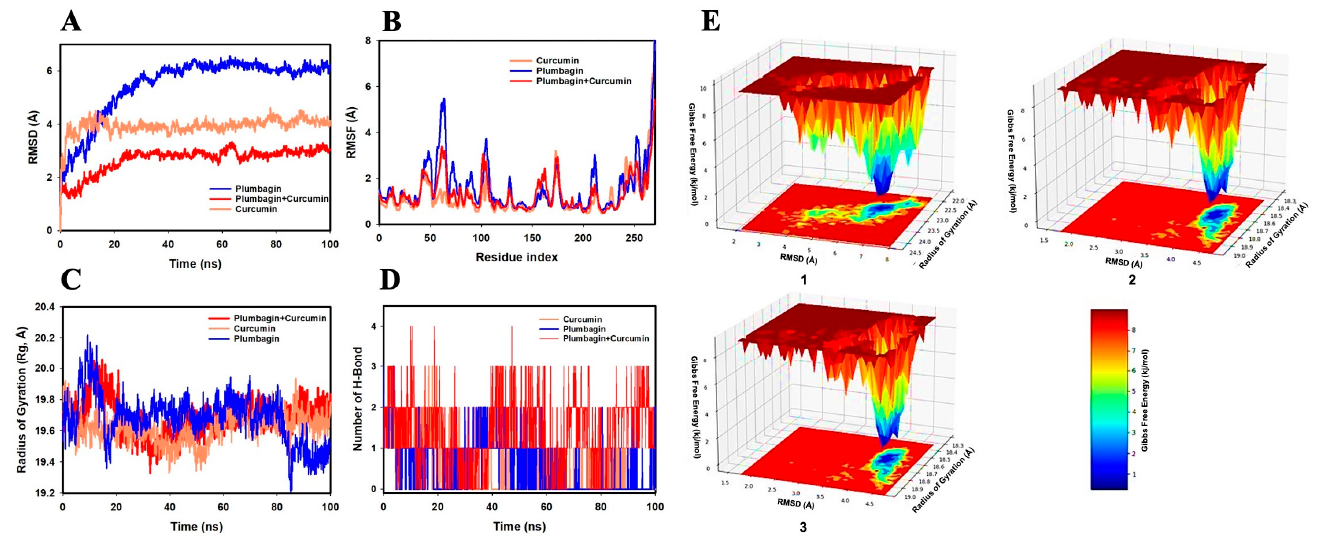
Figure 7. Analysis of MD simulation trajectories of 100 ns time scale for the interaction of curcumin and plumbagin with mTOR. ( A ) RMSD plot displaying the molecular vibration of C α backbone of mTOR-P (blue), mTOR-C (orange), and mTOR-C-P (red). ( B ) RMSF plot showing the fluctuations of respective amino acids throughout the simulation time of 100 ns for mTOR-P (blue), mTOR-C (orange), and mTOR-C-P (red). ( C ) Rg plot for the deduction of compactness of mTOR-P (blue), mTOR-C (orange), and mTOR-C-P (red). ( D ) Number of H-bonds formed between mTOR and plumbagin (blue), mTOR and curcumin (orange), and mTOR and curcumin–plumbagin combination (red). ( E ) The FEL displays the progression of global minima ( Δ G, kJ/mol) of mTOR in presence of ( 1 ) plumbagin, ( 2 ) curcumin, and ( 3 ) curcumin–plumbagin combination with respect to their RMSD (Å) and Rg (Å). The lower right panel displays the energy scale used in the measurement of FEL.